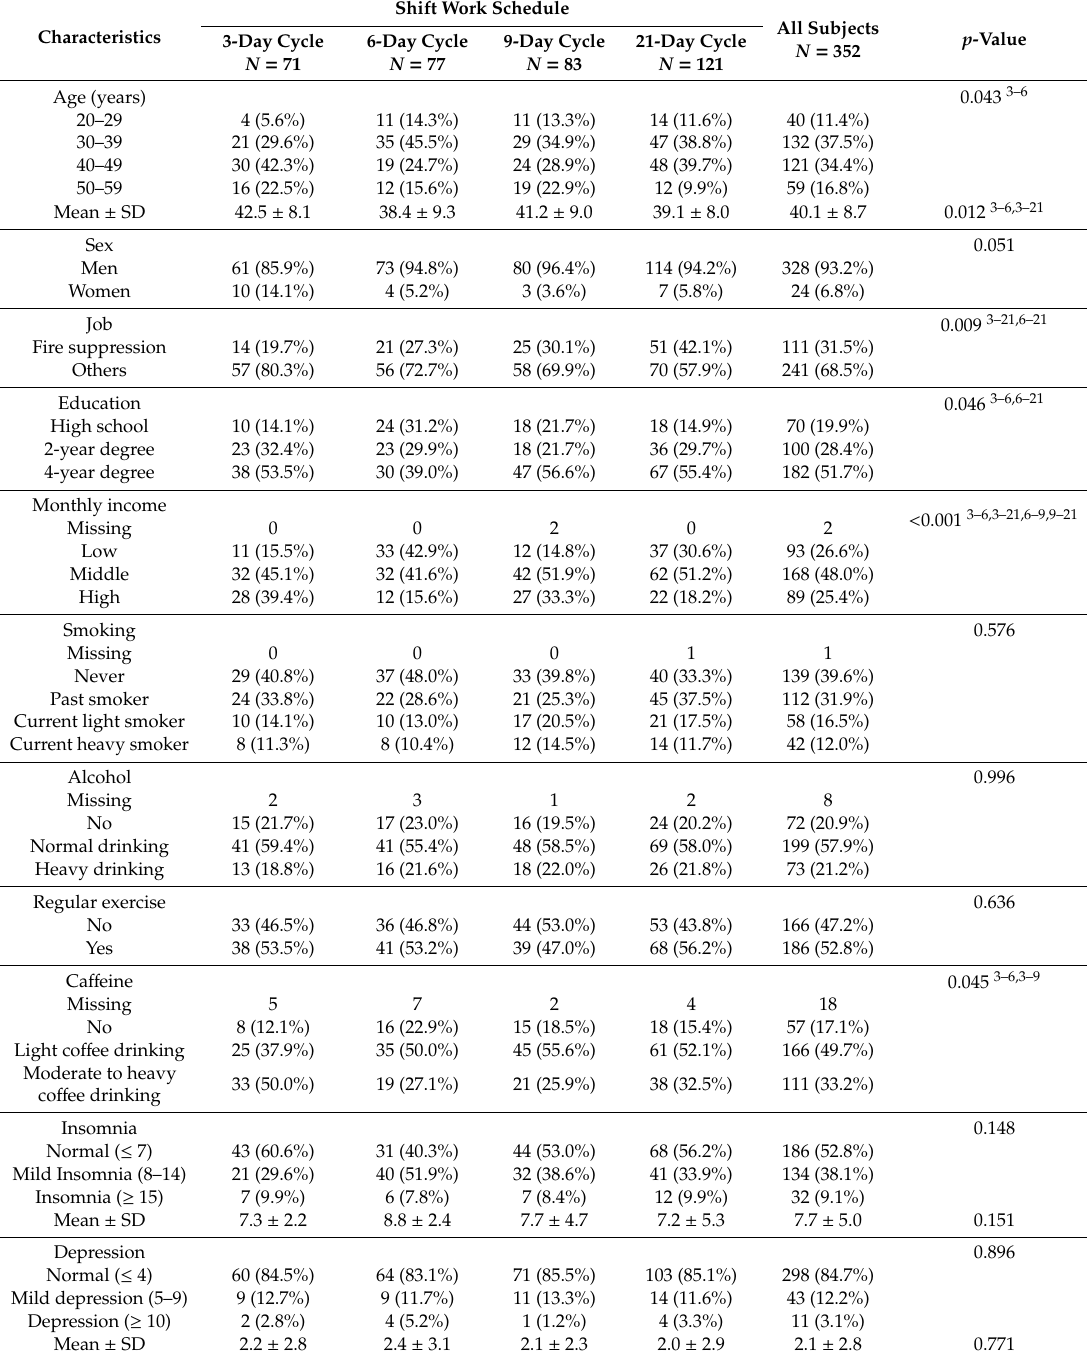
Table 1. General characteristics of the